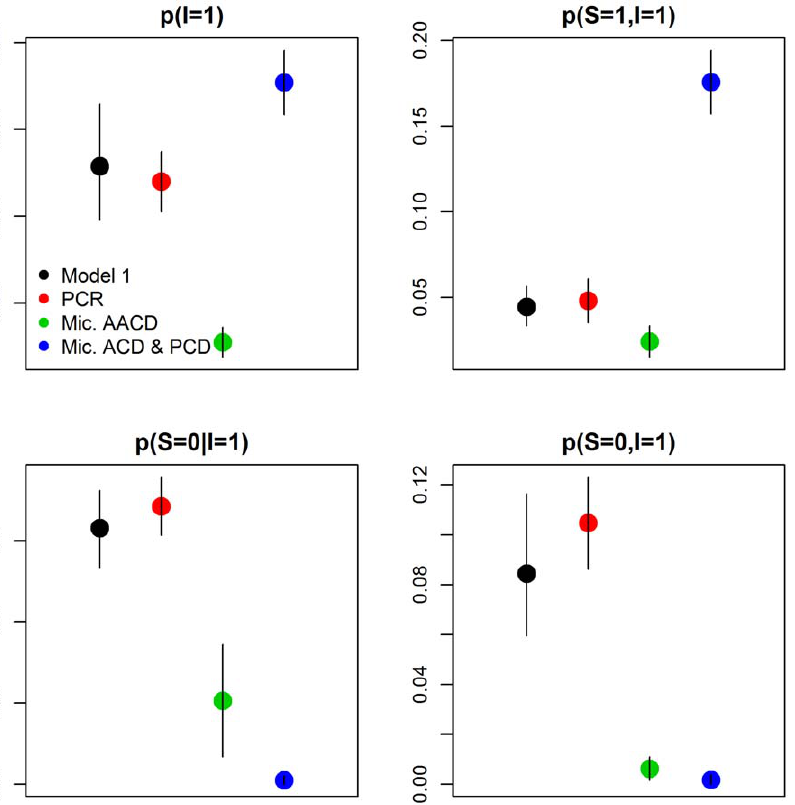
Figure 4. Comparison of summary statistics calculated directly from the data and generated by the proposed model. The summary statistics are infection (i.e., p I ~ 1 ð Þ ) and malaria prevalence (i.e., p I ~ 1, S ~ 1 ð Þ ), proportion of asymptomatic individuals among the pool of infected individuals (i.e., p S ~ 0 j I ~ 1 ð Þ ) and overall proportion of asymptomatic carriers in the population (i.e., p S ~ 0, I ~ 1